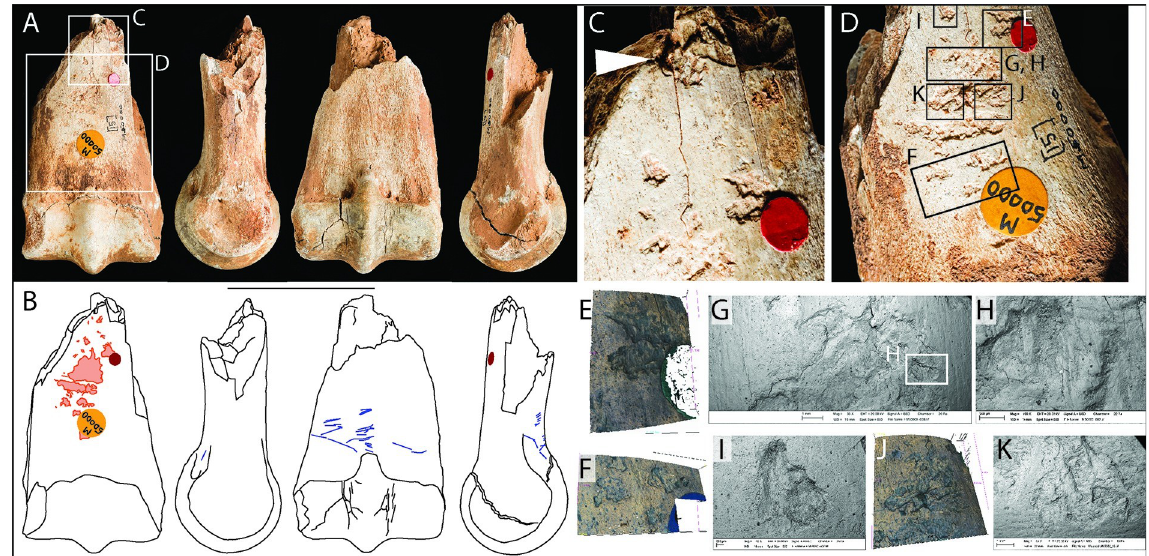
Fig 6. Photographs ( A ) and drawings ( B) of horse distal metacarpal M50000, showing knapping marks (pink) and cut marks (blue) in dorsal, medial, palmar, and lateral views (Scale = 50 mm). SEM micrographs and Alicona images detailing: ( C ) close-up of impact (white arrow) at the apex of the shaft on the dorsal face and incipient crack that extends distally along the shaft; ( D ) close-up of knapping damage with areas of isolated and overlapping scores and pits figured in images E-K